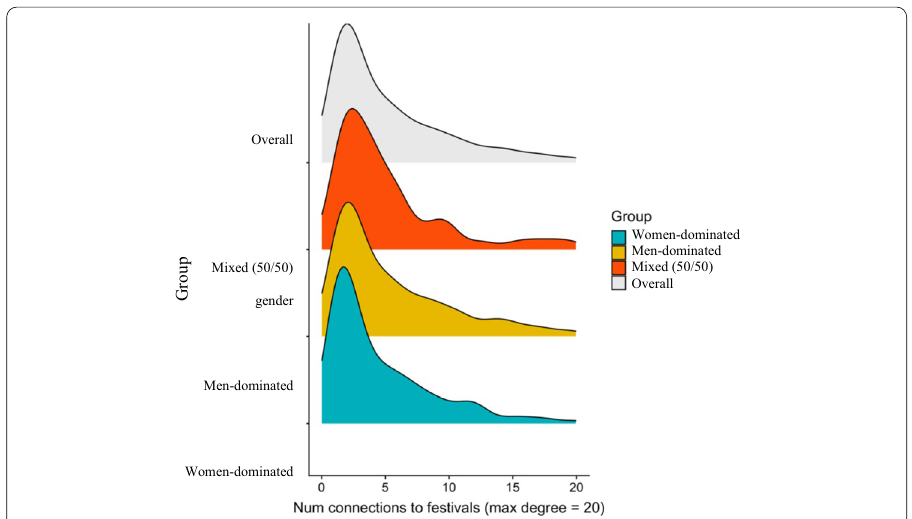
Fig. 15 Connectedness of films by gendered film core creative team composition for second operationalization based on probability density function of degree centrality. Note : The blue line indicates the connectedness for films made by women-dominated core creative teams. The yellow line indicates the connectedness for films made by men-dominated core creative teams. The red line indicates the connectedness for films made by mixed (50/50) core creative teams and the grey line indicates the connectedness for all films regardless of gendered film core creative team composition. For example, the median connectedness for films made by women-dominated core creative teams is 3, the median connectedness for films made by women-dominated core creative teams is 4. Note that for improved graphical display the distributions are cut at a max degree of